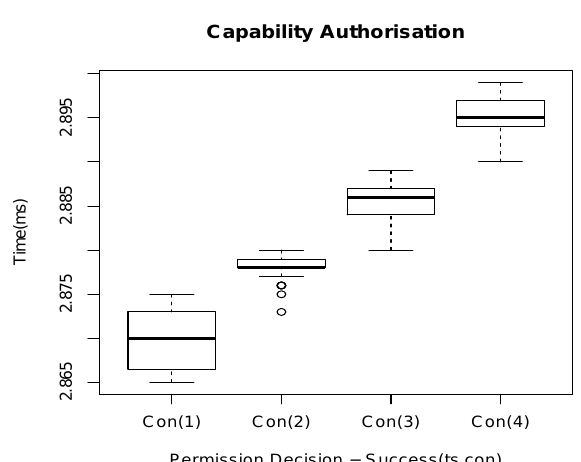
Figure 11. The capability authorisation time for a valid capability i.e. the timestampand condition(s)are valid. In this case we vary the numberof conditionsfromone to